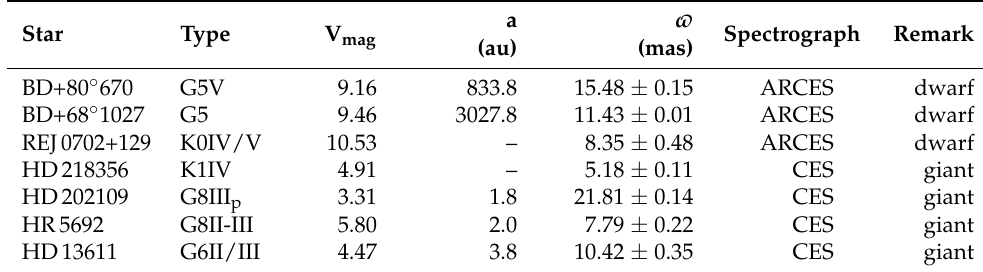
Table 1. Basic data of the seven barium